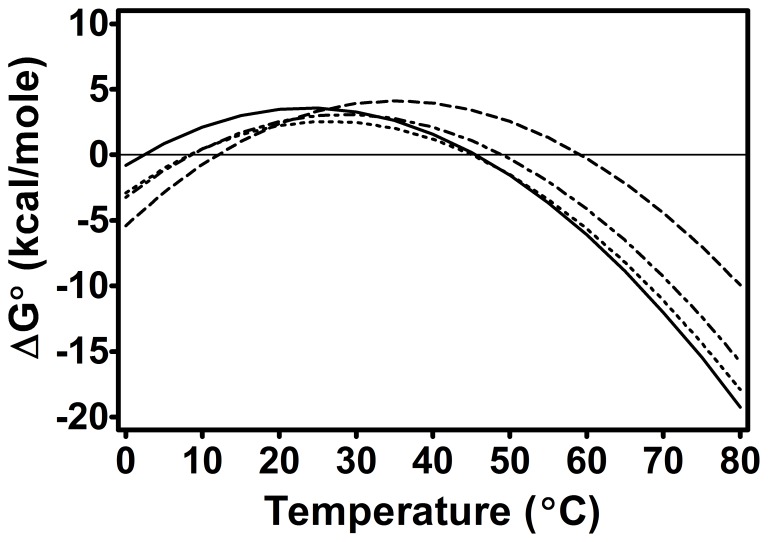
Stability of C2AB as a function of temperature in the presence and absence of ligand.Solid, dashed, dotted, and dash-dot-dash lines represent EGTA, Ca2+, phosphatidylserine, and phosphatidylinositol environments. Note that most proteins of comparable size have maxima in the range of 10–20 kcal/mole [30], [31].